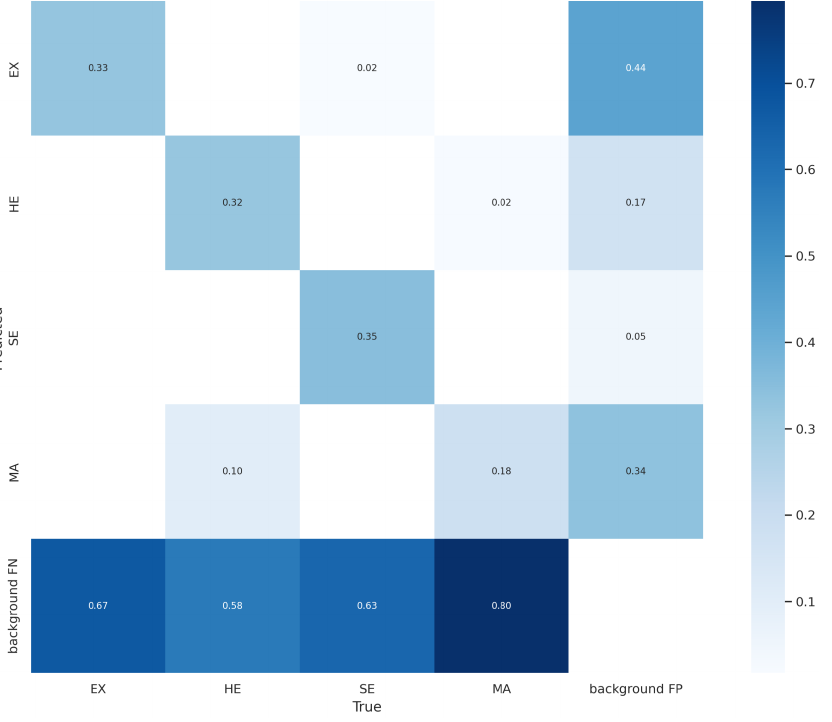
Figure 8. Confusion matrix obtained by the proposed approach with the Adam optimizer and Tilling during the validation step on the Dataset for Diabetic Retinopathy (DDR). EX, hard exudates; HE, hemorrhages; SE, soft exudates; MA, microaneurysms; FN, False Negative; FP, False